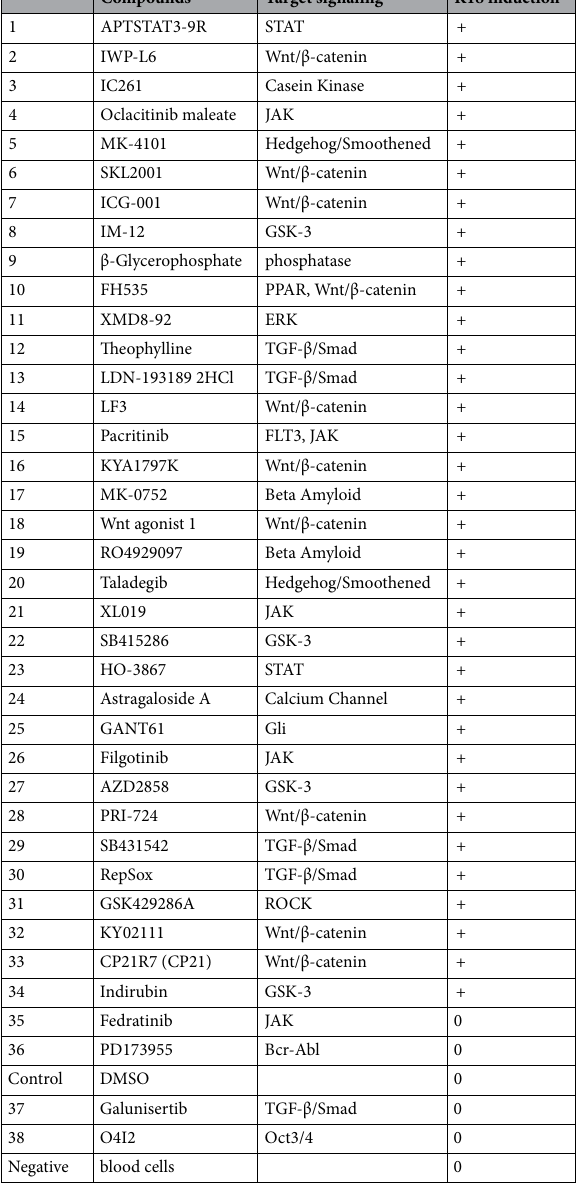
Table 1. Overview of K18 mRNA expression in iEM cells treated with the indicated compounds. Immortalized myoepithelial (iEM) cells under each condition were cultured for 7 days. Gene expression